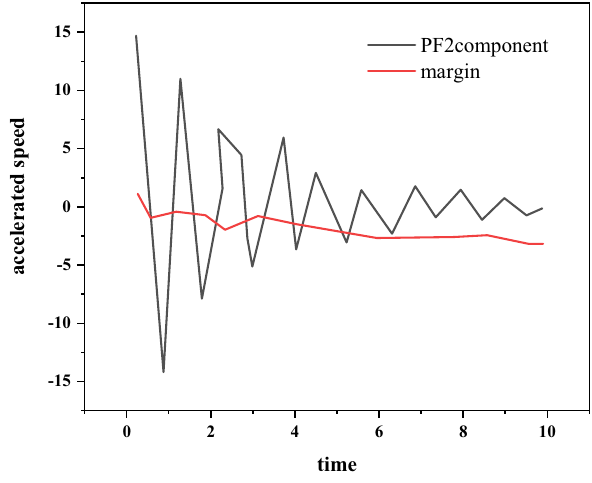
Figure 5: The PF 2 weight and acceleration history